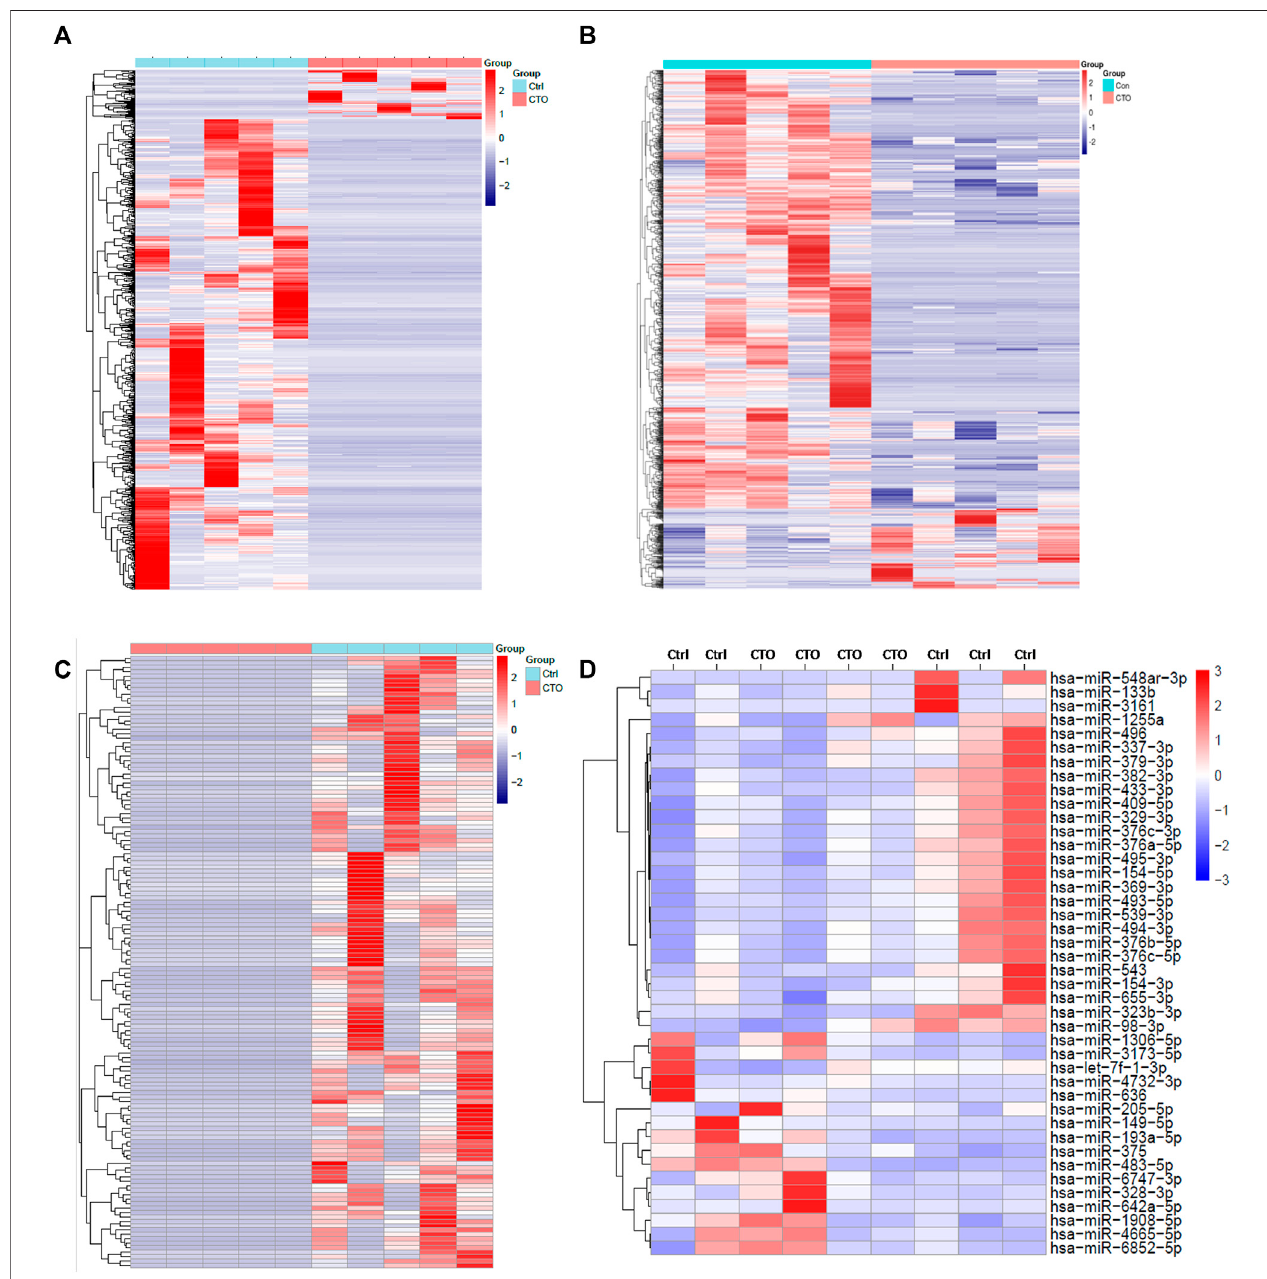
FIGURE 1 | Expression pro fi le of lncRNAs, mRNAs, circRNAs and miRNAs. Hierarchical clustering of DE lncRNAs (A) , mRNAs (B) , circRNA (C) and miRNAs (D) were showed in heatmaps.